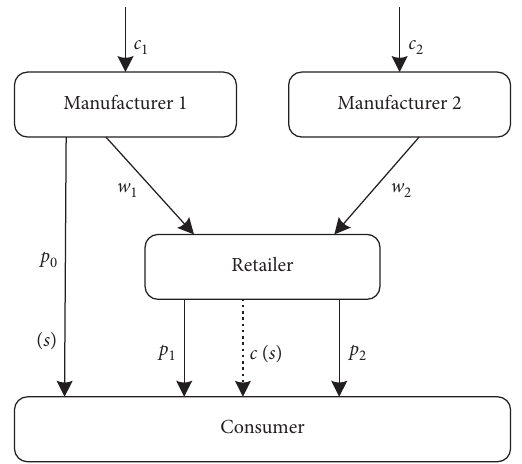
Figure 1: Dual-channel supply chain